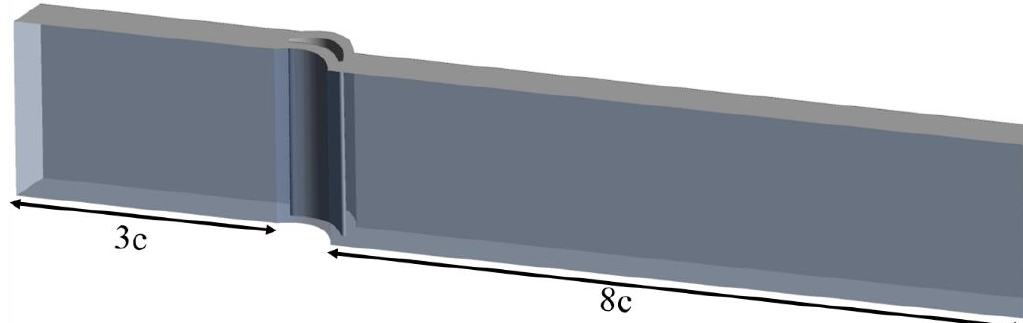
Figure 5. Computational domain.